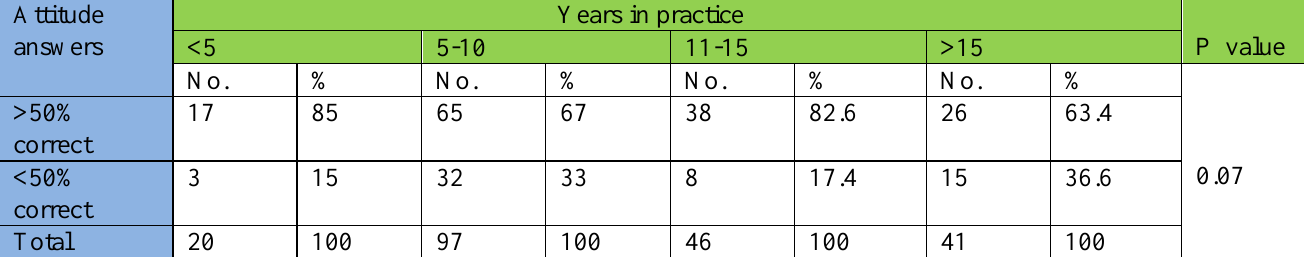
Table.7 relationships between attitude category and years in practice